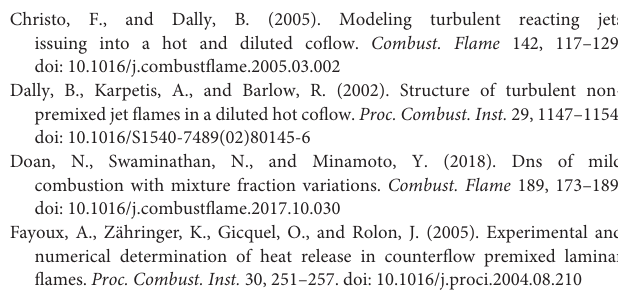
the last 150 mm of the studied domain, the low and wide values of HRR are better captured by combinations of O and OH with carbon